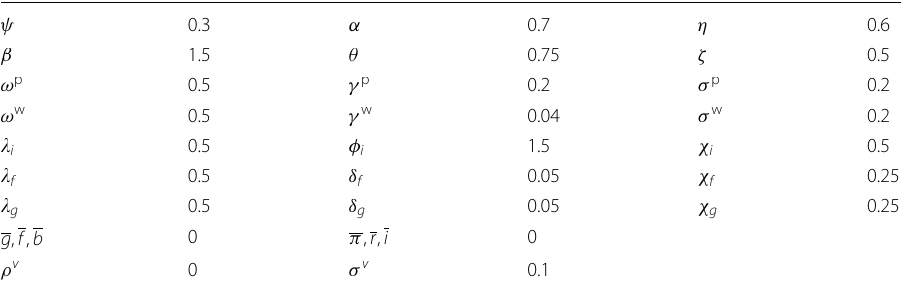
Table 1 Baseline set of